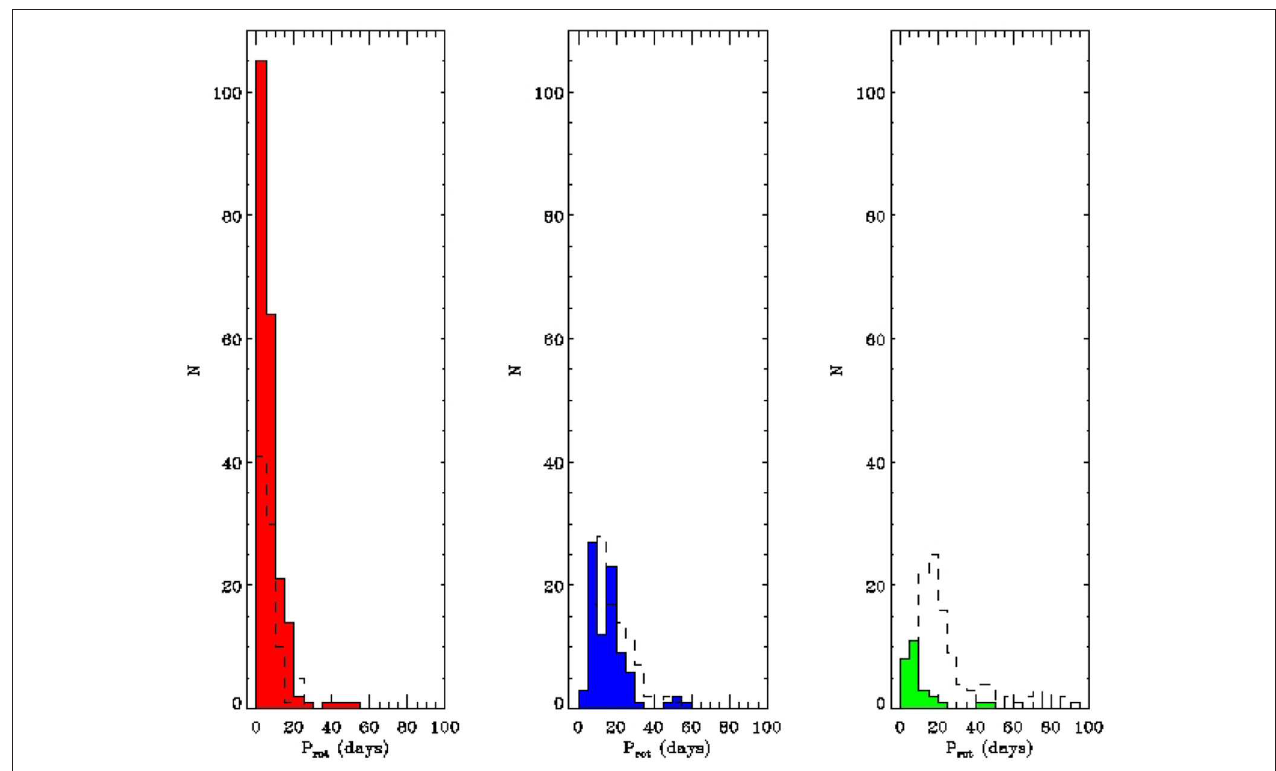
FIGURE 7 | Rotation distribution for the non-oscillating stars selected as in bottom panel of Figure 4 with the same color code. The dash lines in each panel correspond to the rotation distribution of the oscillating stars in each spectral